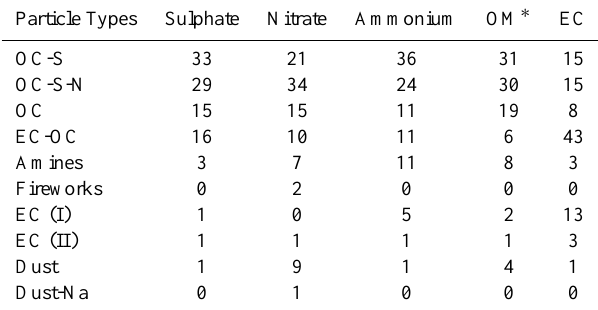
Table 5. Contribution (%) of the 10 particle types to PM 2 . 5 major chemical components in Harrow.